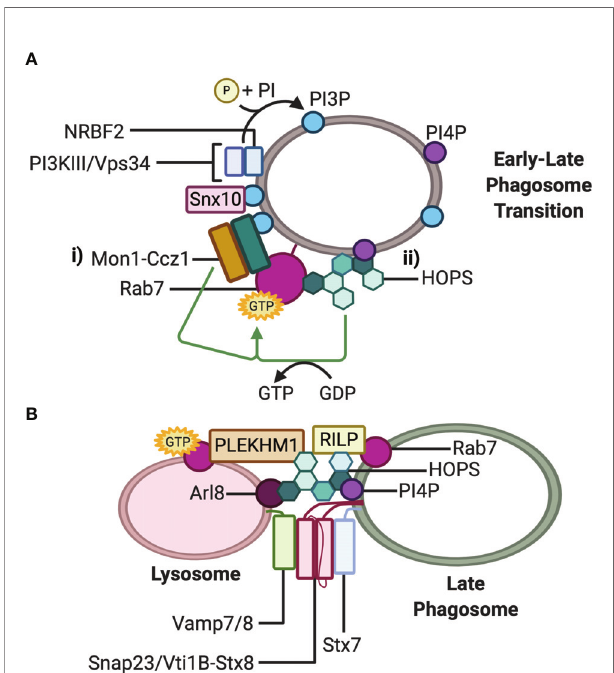
FIGURE 2 | Fusion machinery involved in phagosome maturation. (A) Working models for Rab7 recruitment and activation at the phagosome membrane during maturation: i) The Mon1-Ccz1 complex is recruited directly by PI3P and indirectly by Snx10 and NRBF2-PI3KIII/Vps34. PI3P activates the GEF activity of Mon1-Ccz1; ii) The GEF activity of PI4P-recruited HOPS activates Rab7. (B) Working model of the trans -SNARE complex mediating fusion between the late phagosome and lysosome. The small GTPase Rab7 recruits effectors RILP and Plekhm1, and concurrently with Arl8, additionally recruits the HOPS tethering complex. HOPS docks the late phagosome to the lysosome and stabilizes the trans -SNARE Stx7-Snap23-Vamp7/8 or Stx7-Vti1b-Stx8-Vamp7/8 complex at the point of membrane fusion. Note that either Plekhm1, Arl8, PI4P, or RILP on either lysosomes or phagosomes bind to HOPS Vps41 at one time, while RILP can also bind HOPS